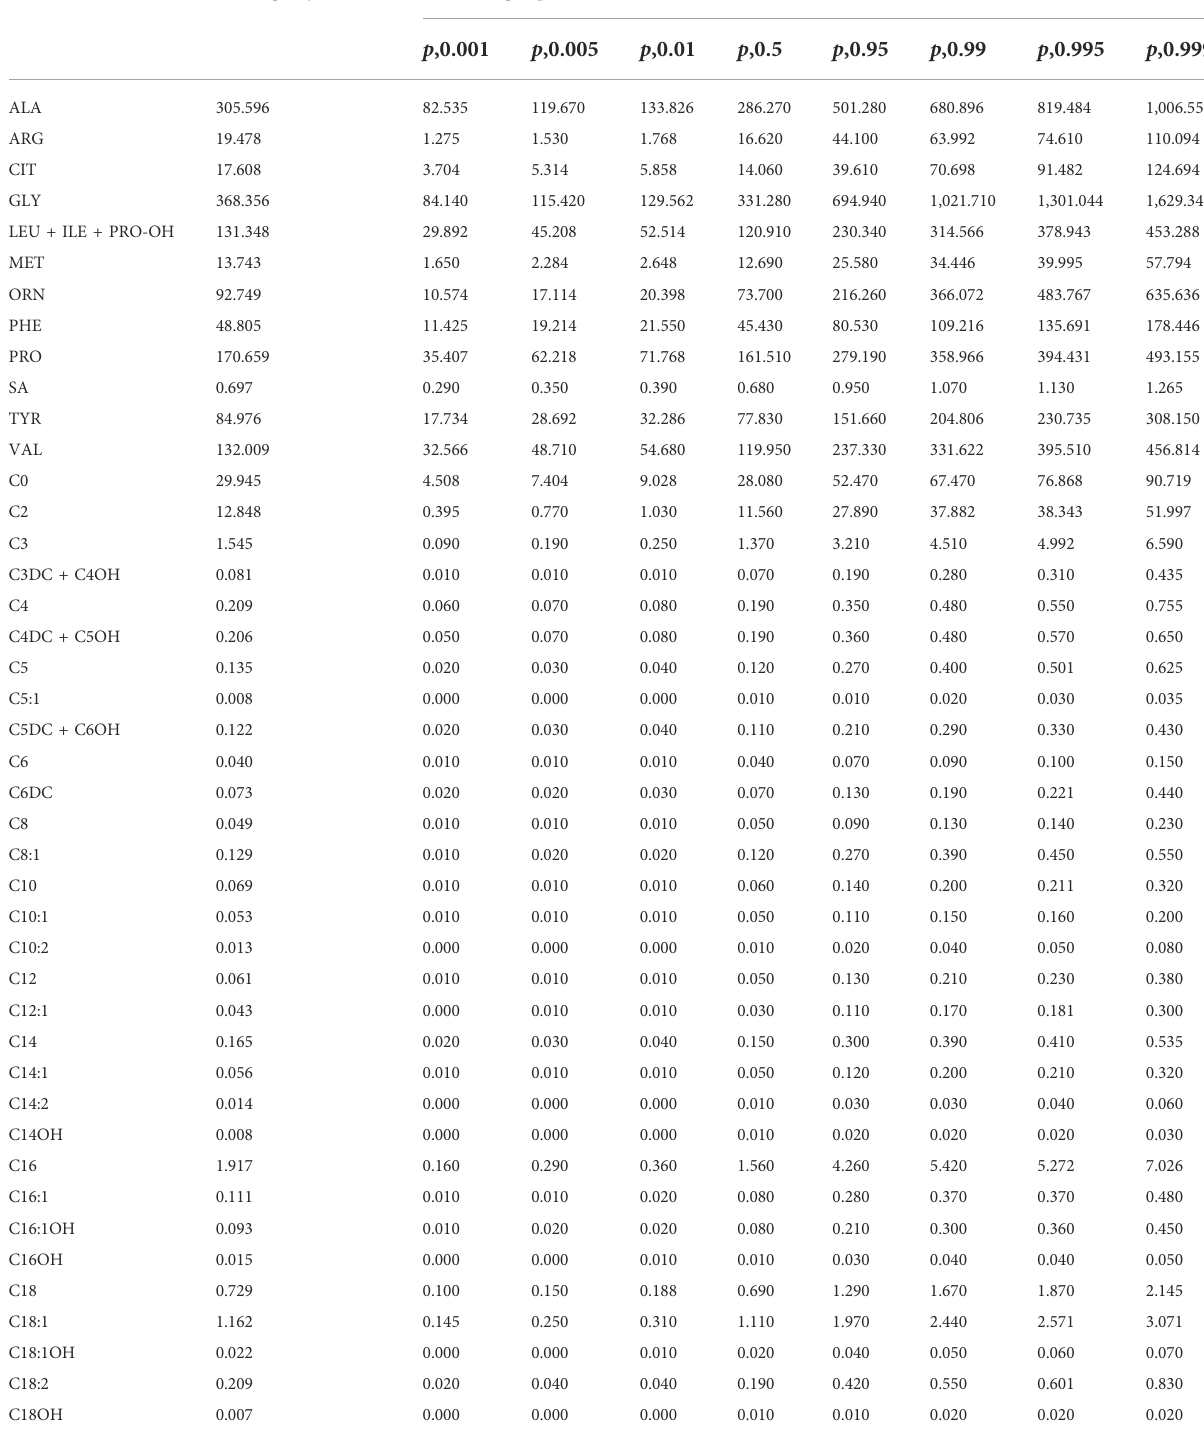
TABLE 2 Statistical results of amino acids and acylcarnitines of neonates from the Tibet Autonomous